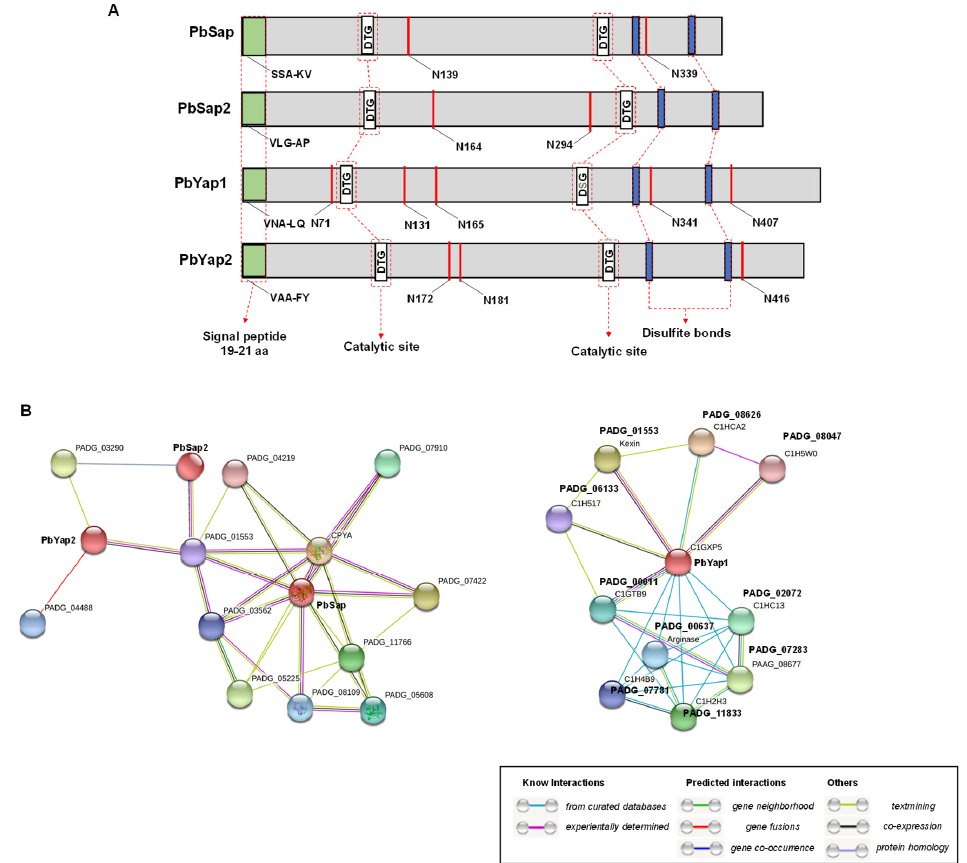
Figure 1. ( A ) Schematic presentation of aspartic protease of P. brasiliensis. Four encoded genes